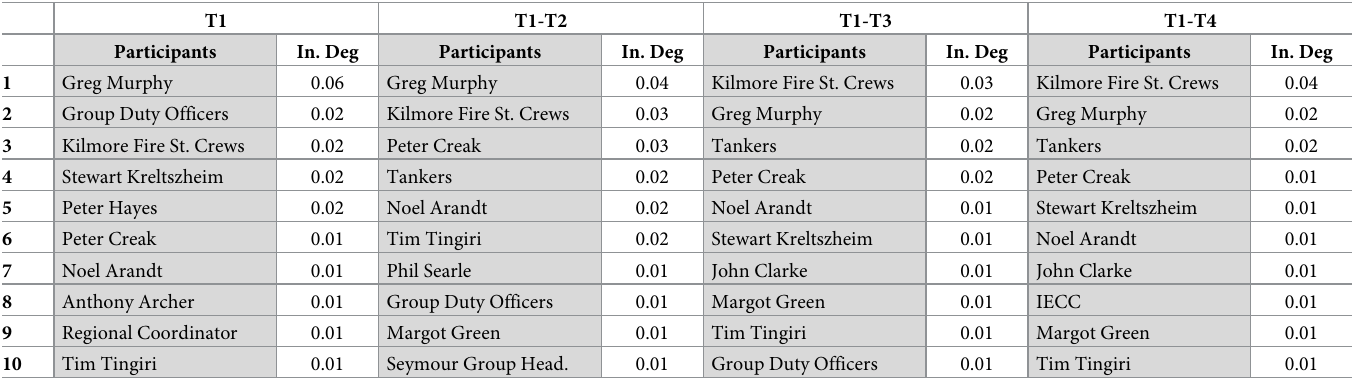
Table 2. Top 10 provider personnel in the Kilmore East inter-personal coordination network (normalized in-degree centrality). T1